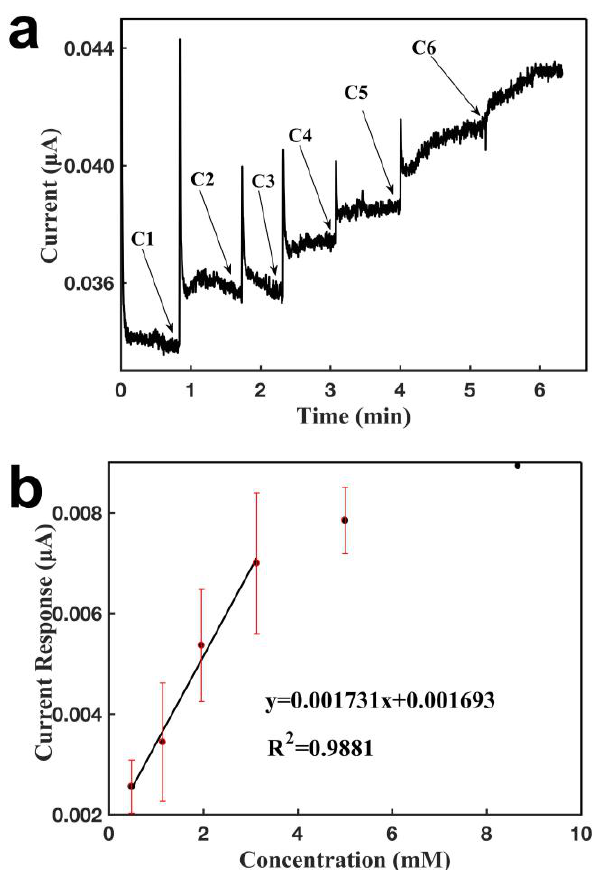
Figure 4. Characterization of a glove sensor based on two CNT electrodes for the detection of lactate. Operating potential: 0.6 V of working electrode vs reference electrode (CNT). ( a ) Current-versus-time response curve upon the additions of lactate. C1: 0.48 mM, C2: 0.66 mM, C3: 0.82 mM, C4: 1.17 mM, C5: 1.88 mM, C6: 3.65 mM. ( b ) Calibration curve for the detection of lactate. Each error bar was from three measurements.